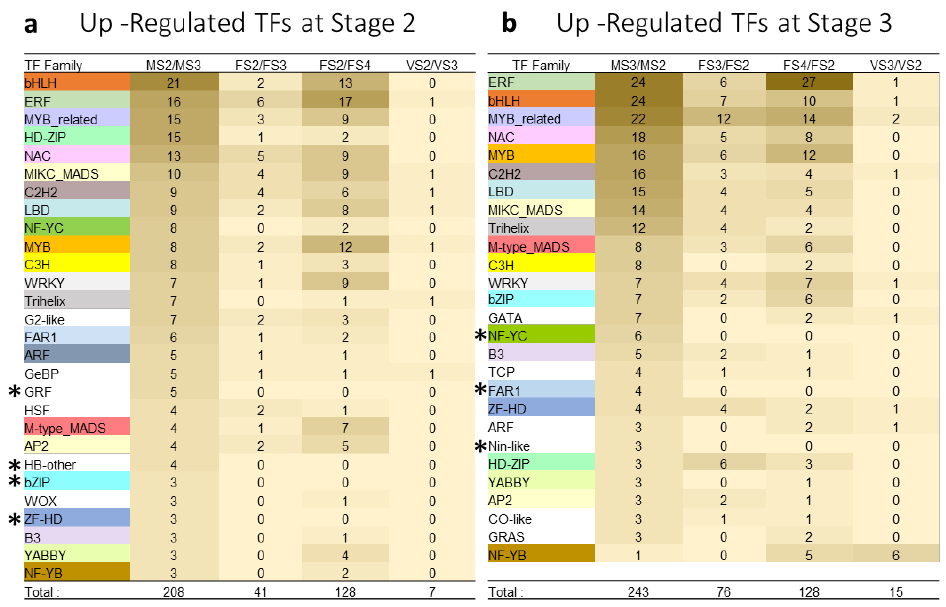
Figure 4. Heat-map of up-regulated transcription factors (TF) grouped into families involved in cone development. Included are families which showed at least three up-regulated members in at least one meristem type in the early ( a ) and late ( b ) stages of cone development. Color intensity of the heat-map reflects the number of genes. Common families between the early and late stages share the same color, while uncommon families are not colored. Asterisks indicate TF families found only in the male cone. MS2, Male Stage 2; MS3, Male Stage 3; FS2, Female Stage 2; FS3, Female Stage 3; FS4, Female Stage 4; VS2, Vegetative Stage 2; VS3, Vegetative Stage 3.